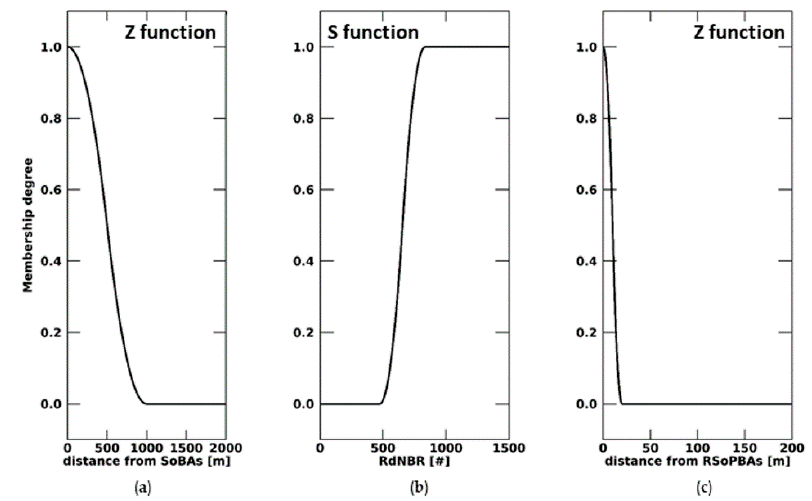
Figure 6. Fuzzy membership functions defined for ( a ) distance from the set of burned areas (SoBAs), ( b ) RdNBR value, and ( c ) distance from the refined set of potentially burned areas (RSoPBAs).